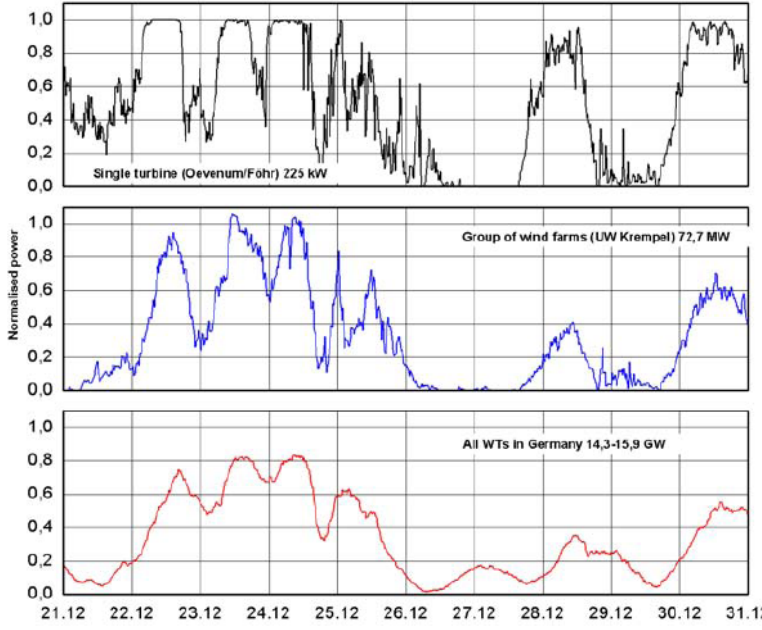
Figure 45. Normalised power output from a single wind turbine (top), an group of turbines (middle), and al turbines in Germany (bottom; after [211]). © 2007 VTT, reproduced with permission from VTT Working Papers 82.